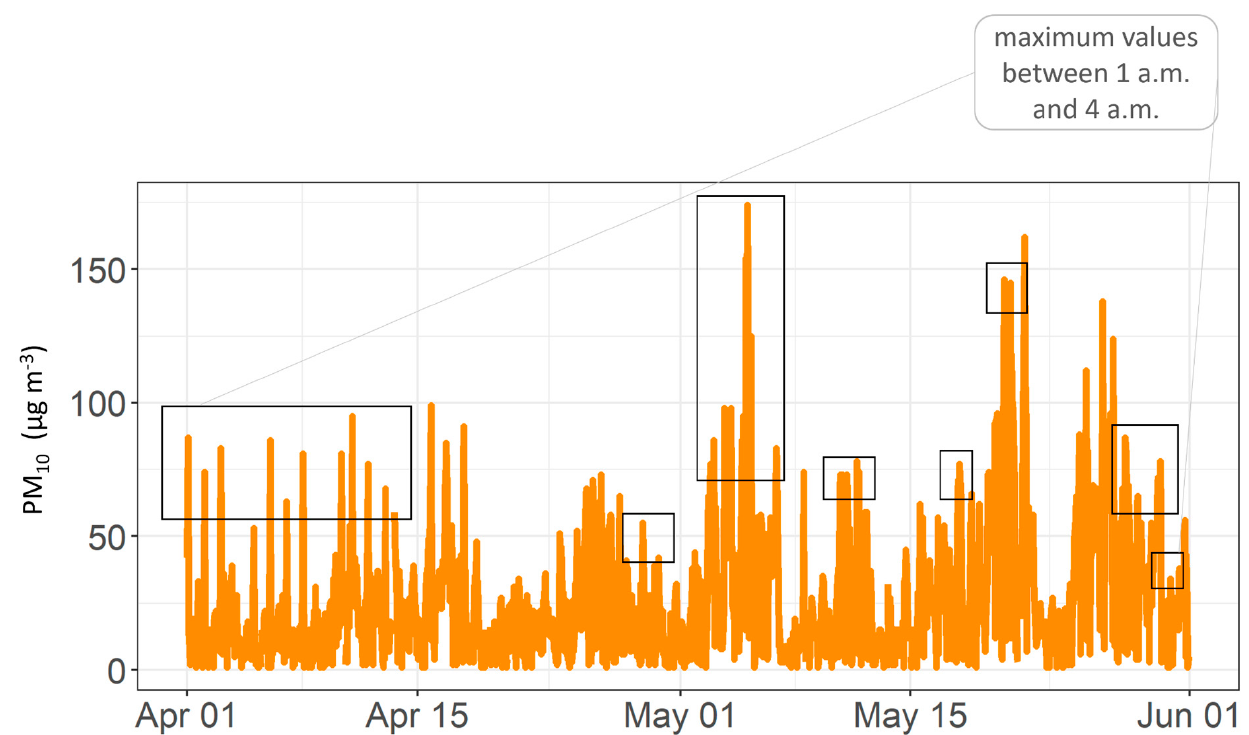
Figure 5. Hourly concentrations of PM 10 at Capuava AQS, during the episode (April to May 2021). Rectangles represent the peaks observed from 1:00 a.m. to 4:00 a.m.